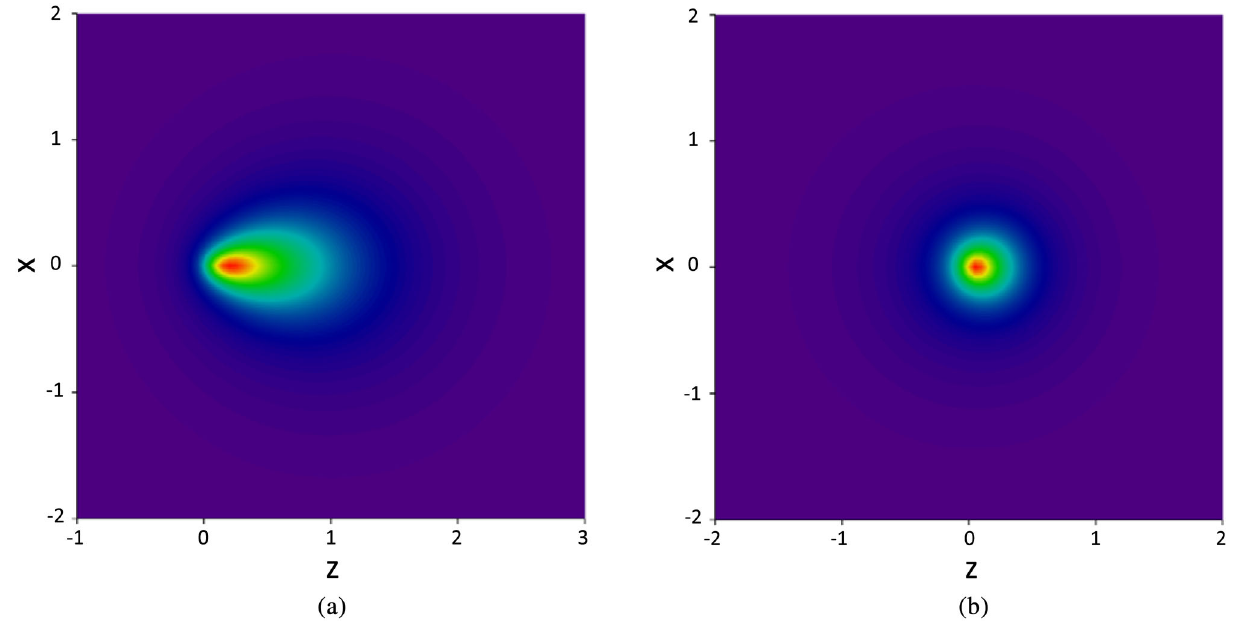
¼ 1 . z t ¼ π = 2 p